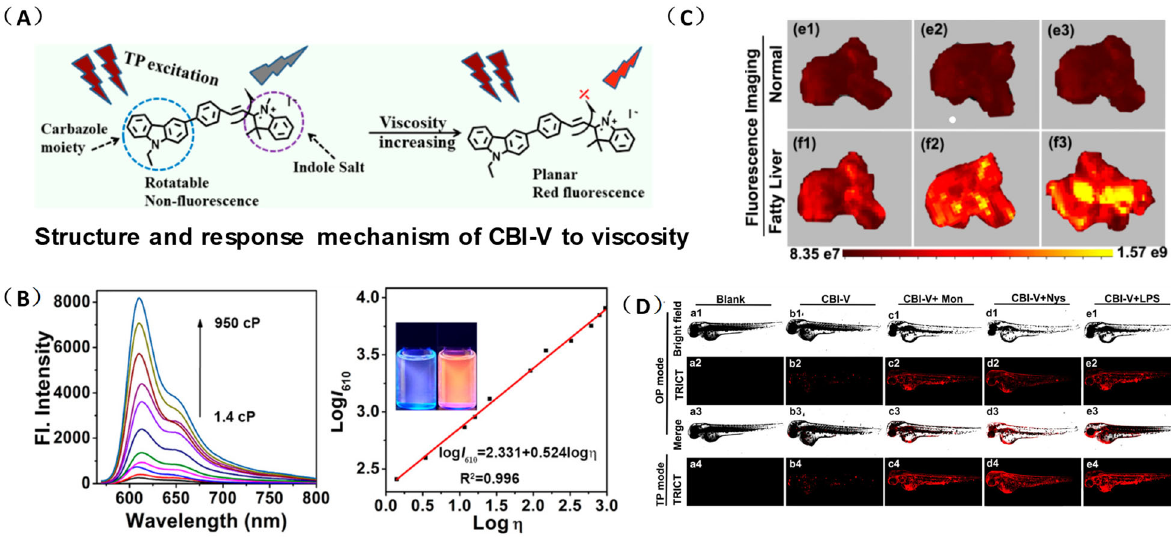
Figure 2. ( A ) The structure and reaction mechanism of the probe CBI-V . ( B ) Left: Fluorescence spectra of 10 µ M CBI-V in methanol–glycerol systems at various ratios ( λ ex = 520 nm). Right: Linear relationship between log I610 and log η . ( C ) Fluorescence imaging of mitochondrial viscosity with CBI-V in normal liver and fatty liver. ( D ) Fluorescence imaging of zebrafish [31]. Copyright © 2023 American Chemical Society.